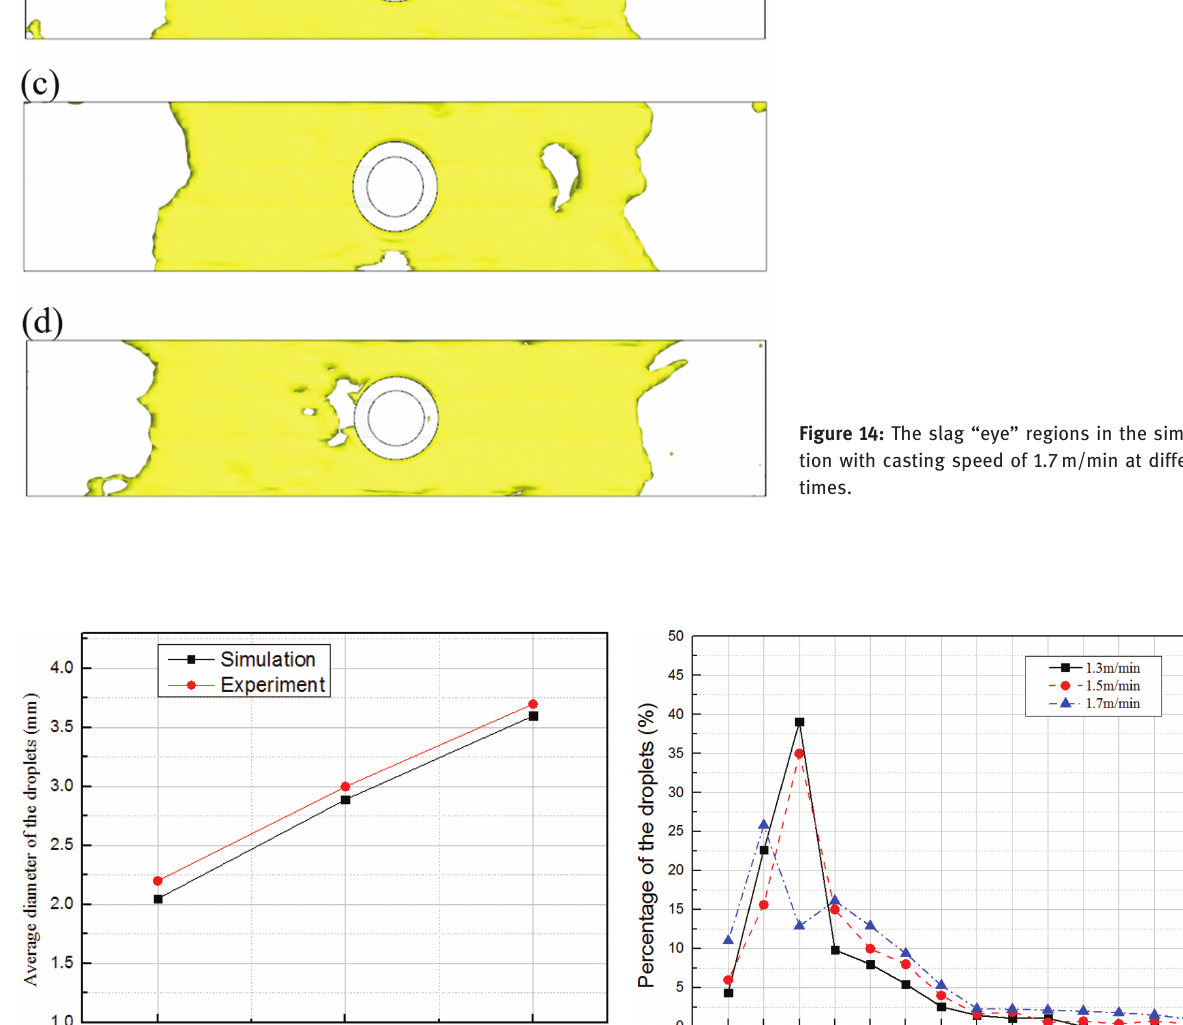
Figure 16: The size distributions of the entrained droplets during a 10 s period time at different casting